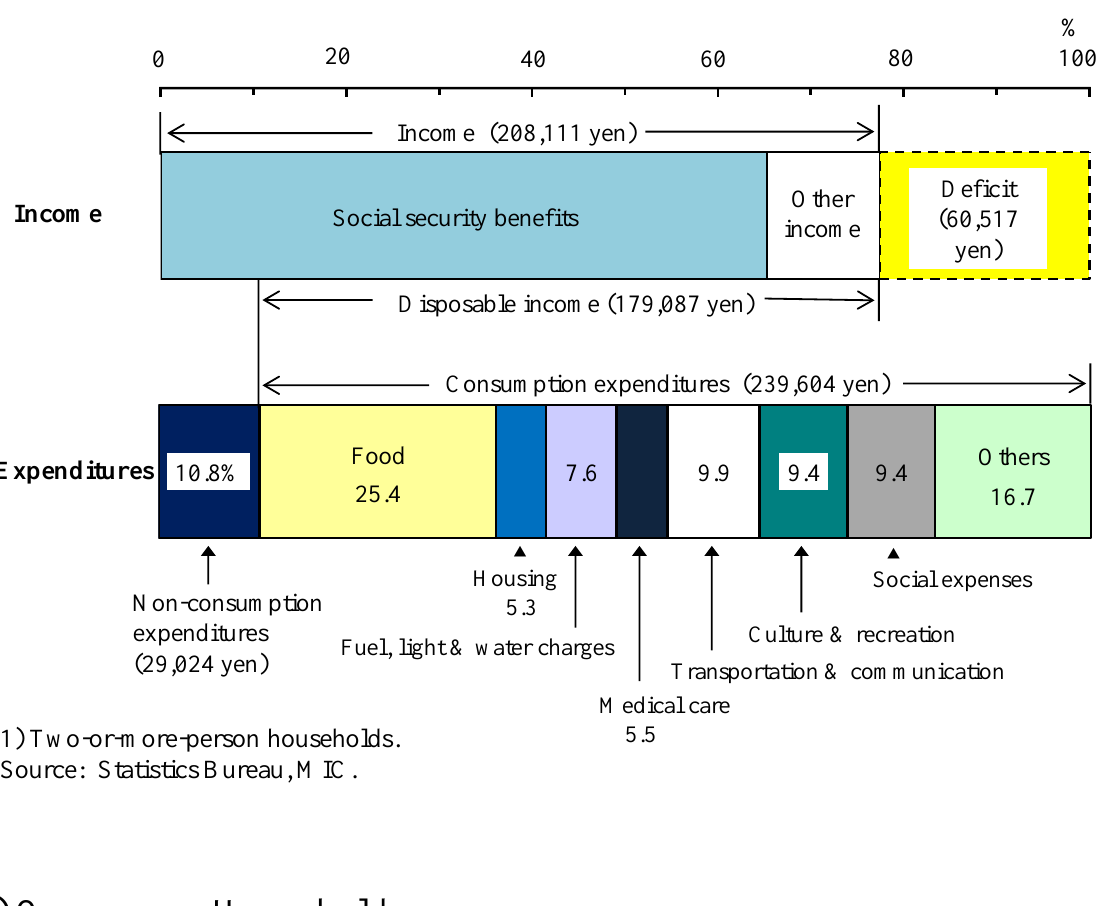
Figure 13.5 Average Monthly Income and Expenditures (Non-working elderly households 1) )